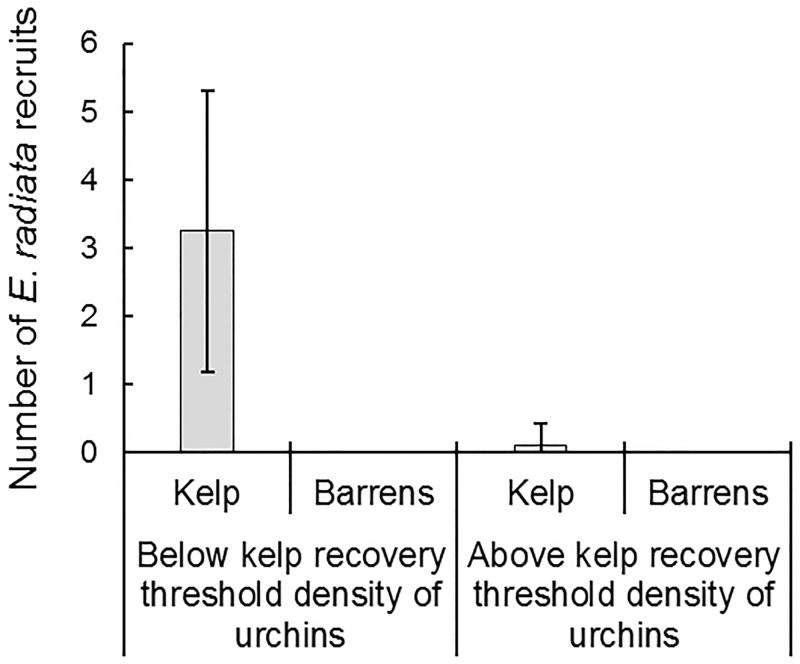
E. radiata recruitment.Abundance (mean ± SE) of E. radiata recruits on reefs above and below the critical urchin density (4 urchins m-2) for kelp recovery after 13 months (‘Kelp’ and ‘Barrens’ refers to the initial states of reefs). Nutrient enhancement did not influence recruitment and therefore data for ‘nutrient enhanced’ and ‘ambient nutrient’ reefs were pooled for display.